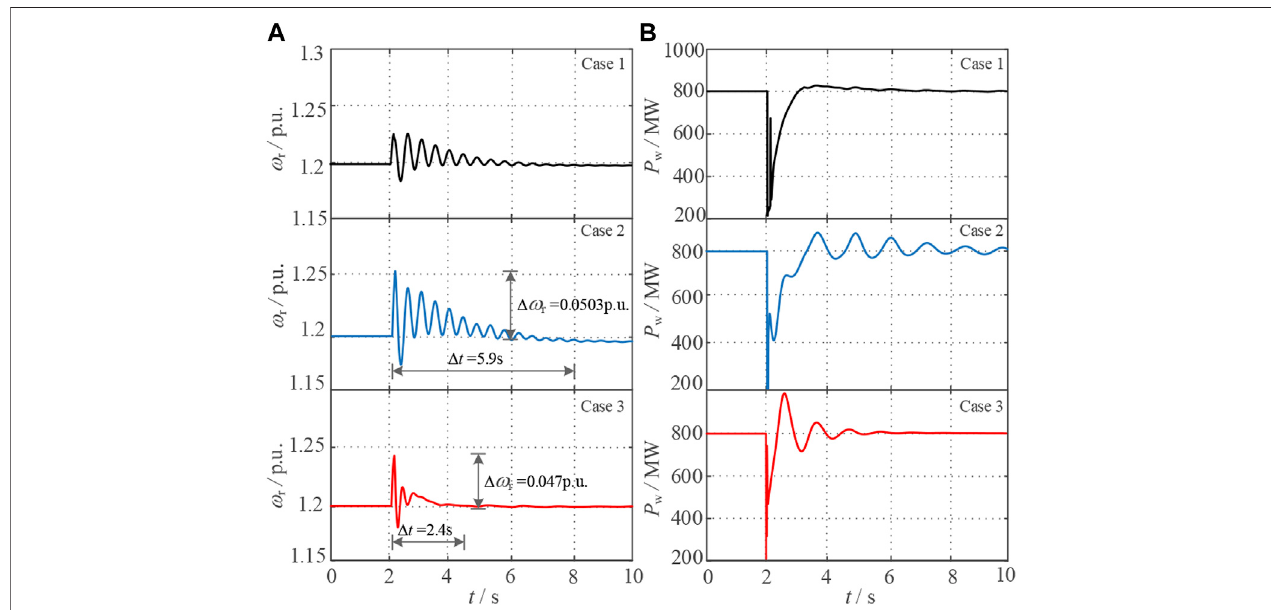
FIGURE 8 | Figure shows the transient response curve of the wind turbine, in which (A) is the rotational speed curve of the wind turbine under the three simulation test cases, and (B) is the output power curve of the wind turbine.